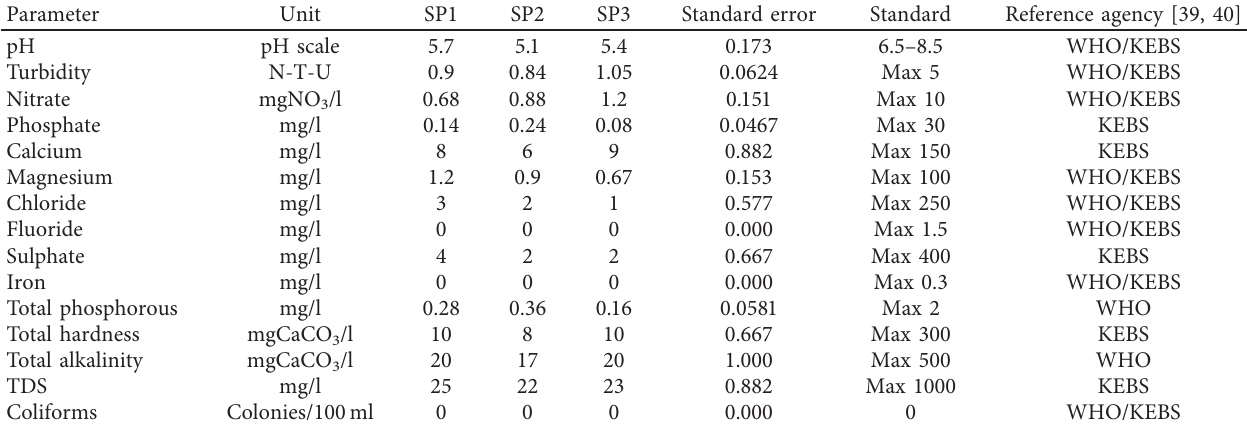
Table 2: Parameter characterization, recommended standards, and